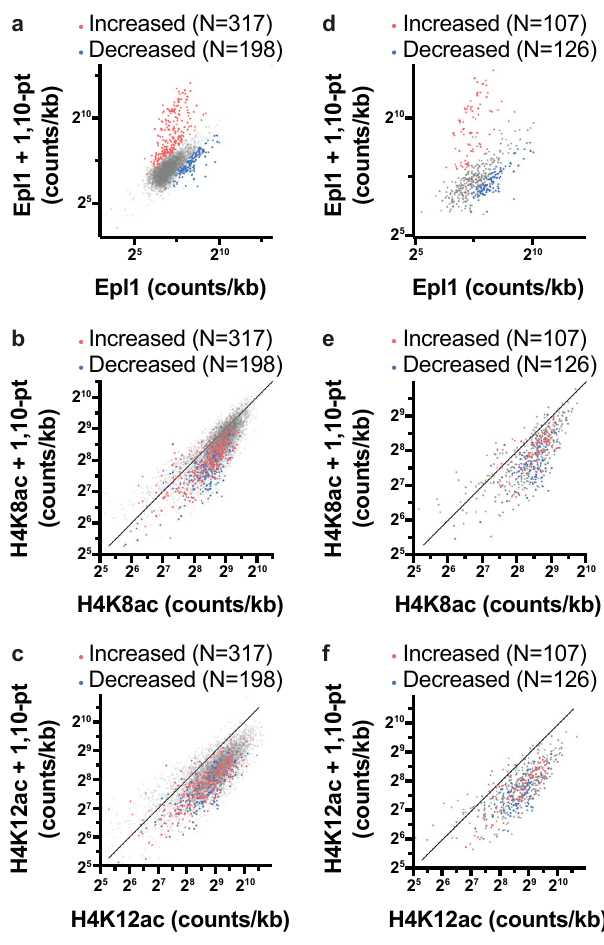
Fig. 1 Transcription inhibition by 1,10-phenanthroline (1,10-pt) does not impact Epl1 occupancy at most promoters. Scatter plots comparing the effect of 1,10-pt on fragment midpoint counts from Epl1 ( a , d ), H4K8ac ( b , e ), or H4K12ac ( c , f ) ChIP-seq, over promoters ( a and d ) or associated + 1 nucleosomes ( b , c , e , and f ) of all (5542) genes ( a , b , c ) or of 562 genes with NDR Epl1 peaks identi fi ed in MNase ChIP-seq in control cells ( d , e , f ). Promoters with >1.5 fold-change in Epl1 using an adjusted p -value < 0.1 (DESeq2 ’ s binomial test 2 ) are shown in red (increased) or blue (decreased). In b , c , e , and f , the line is: y = x +